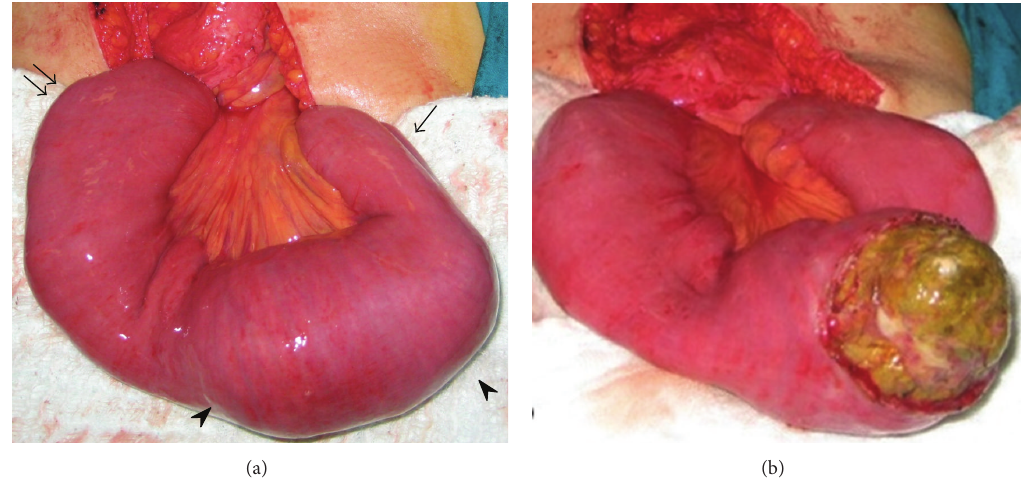
Figure 3: Intraoperative view of 62-year-old female patient. Intraluminally located bezoar (arrow heads), dilated proximal segments (double arrow), and nondilated distal segments (arrow) are